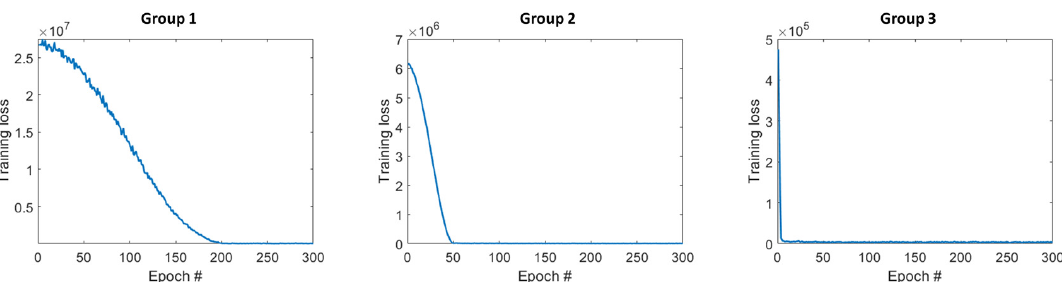
Figure 24. Training loss of different DRF groups with U-net model for 99m Tc.